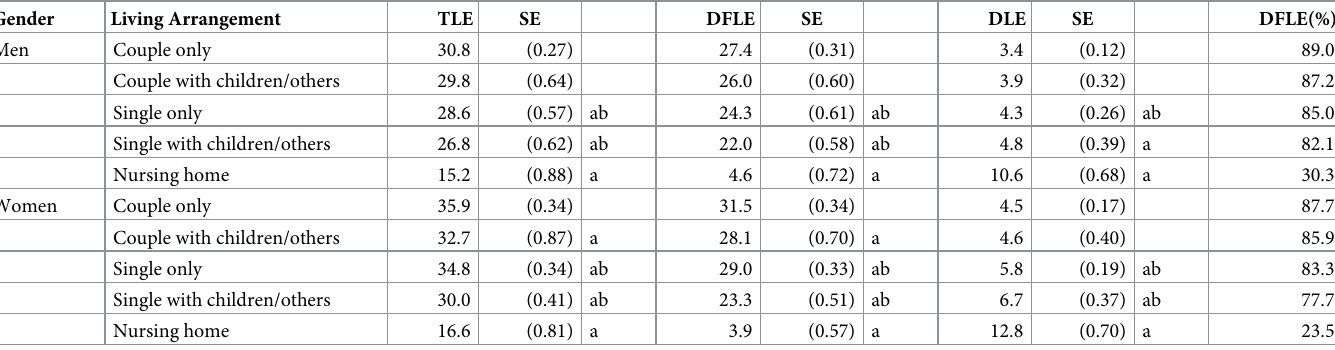
Table 4. Total, disability-free, and disabled life expectancy by gender and living arrangement for non-Hispanic whites at age 50: Population-based estimates.